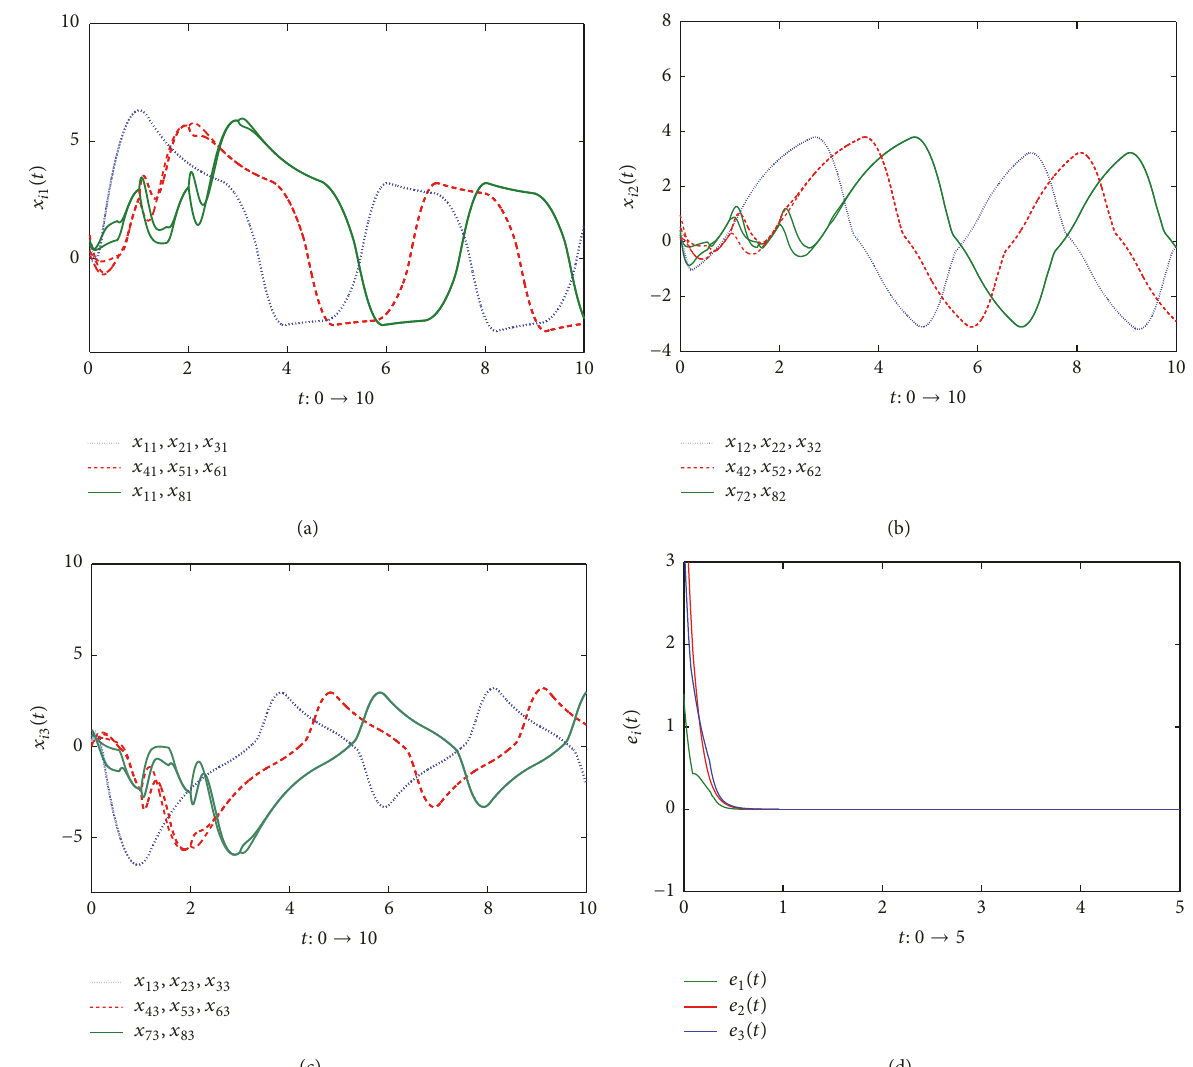
Figure 2: Cluster-delay synchronization of the network (33). (a), (b), and (c) show the time evolutions of the state variable of the 8 nodes splitting into three different clusters, and (d) describes the time evolutions of the cluster errors.